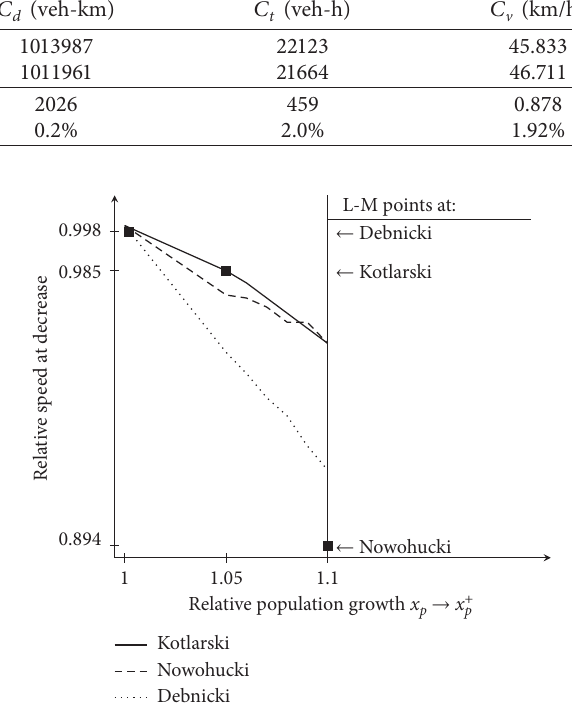
Figure 4: Relative speed decrease at alternative bridges against population